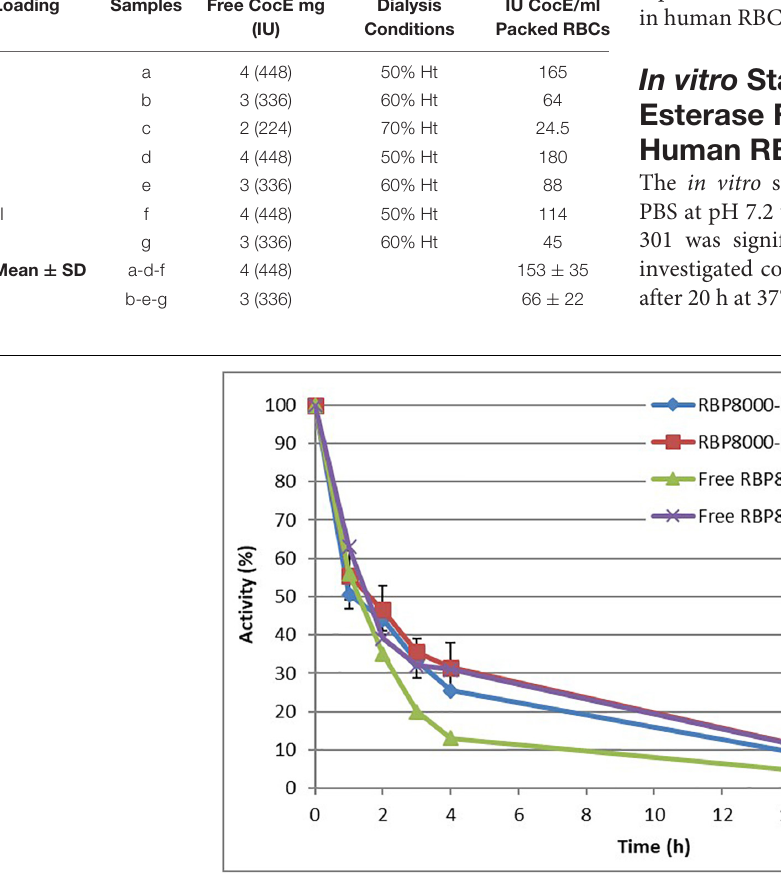
Frontiers in Physiology |